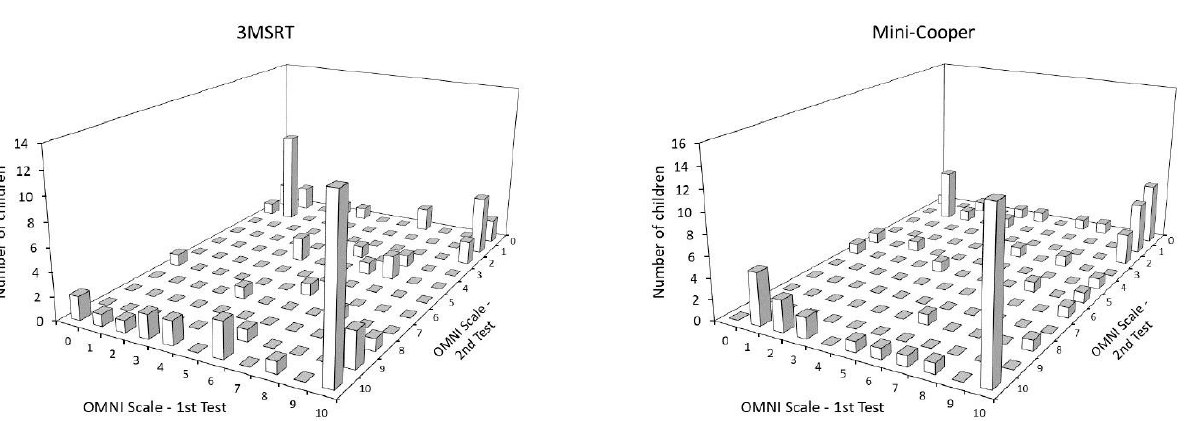
Figure 2. Results of the OMNI Scale for the three-minute shuttle run test (3MSRT) and the Mini- Cooper test, administered twice each.